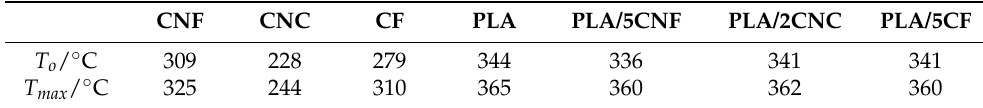
Figure 5. TG ( a , d ) and DTG ( b , e ) curves and plots of ln[ln(W 0 /W T )] vs. T–T s ( c , f ) of NCF, PLA film and PLA composite films. Table 1. Thermogravimetric data of NC, PLA film, and composite films.